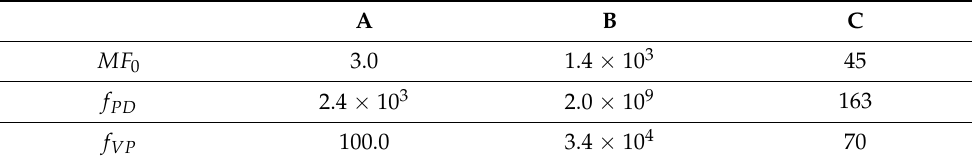
Table 4. Parameter Values for Lower Projectile Density